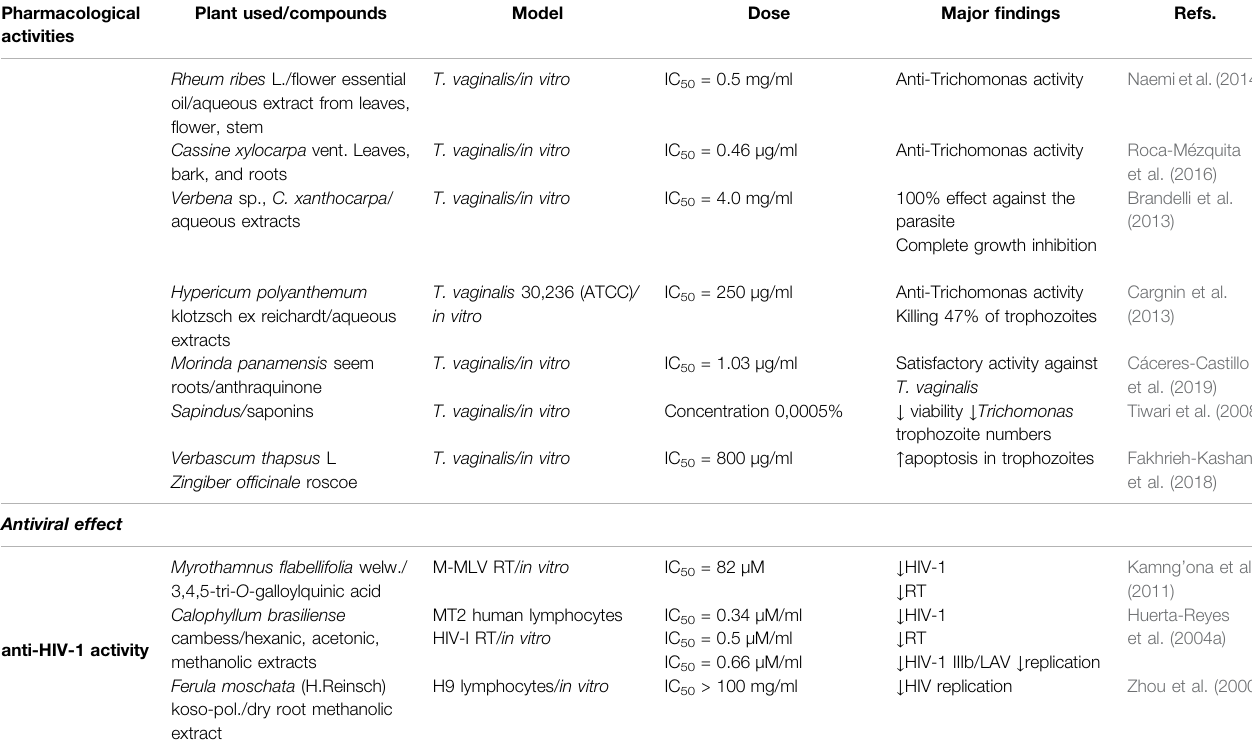
TABLE 2 | ( Continued ) Pharmacological properties of selected plants/natural compounds against STDs